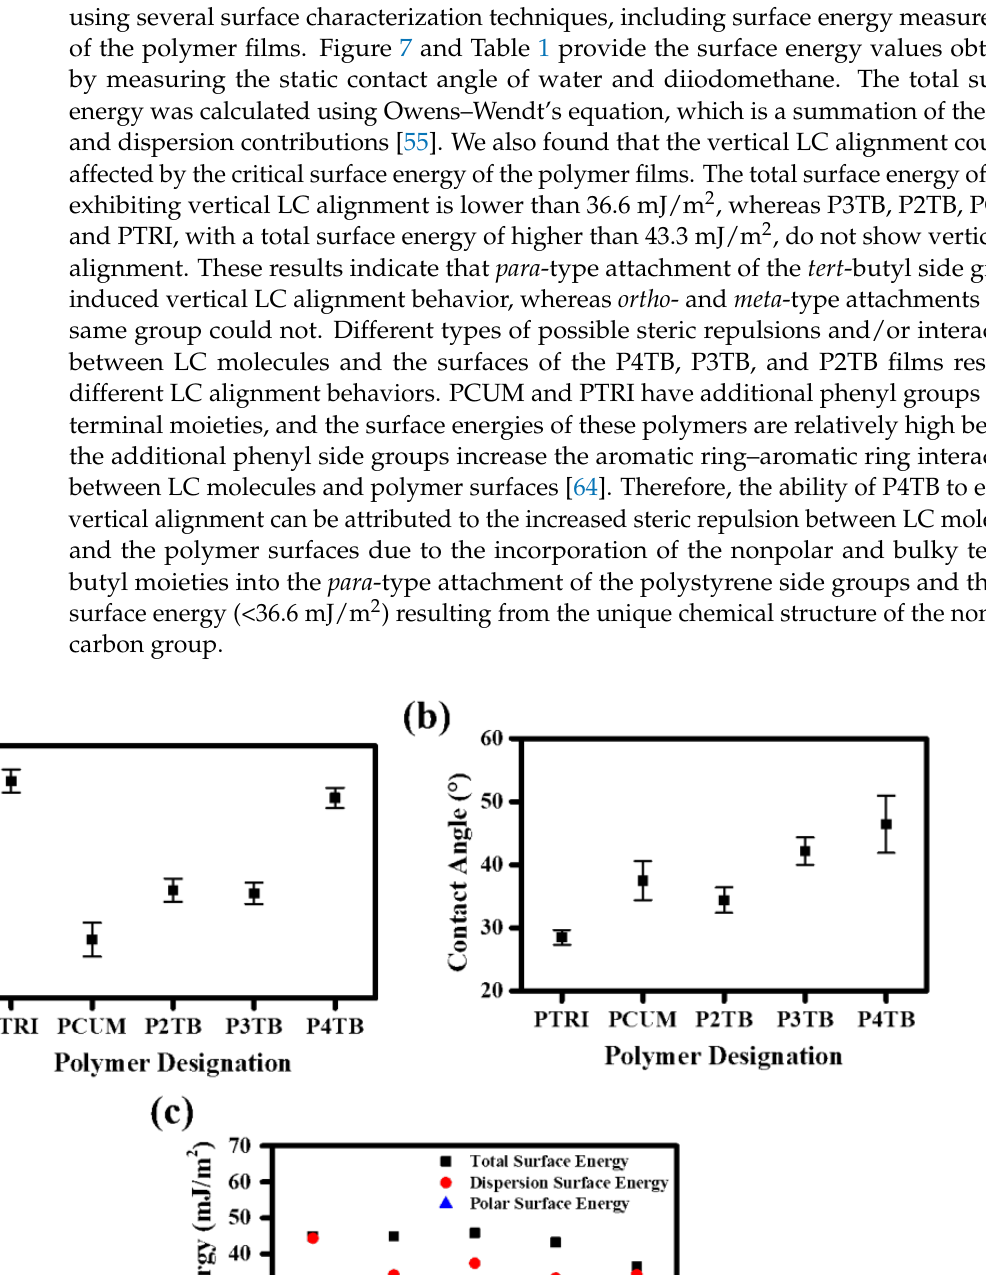
O a Measured from static contact angles. b Calculated from Owens–Wendt’s equation. c Circle (O) and cross (X) indicate pol- ymer film have vertical and random planar, tilted LC aligning ability, respectively.